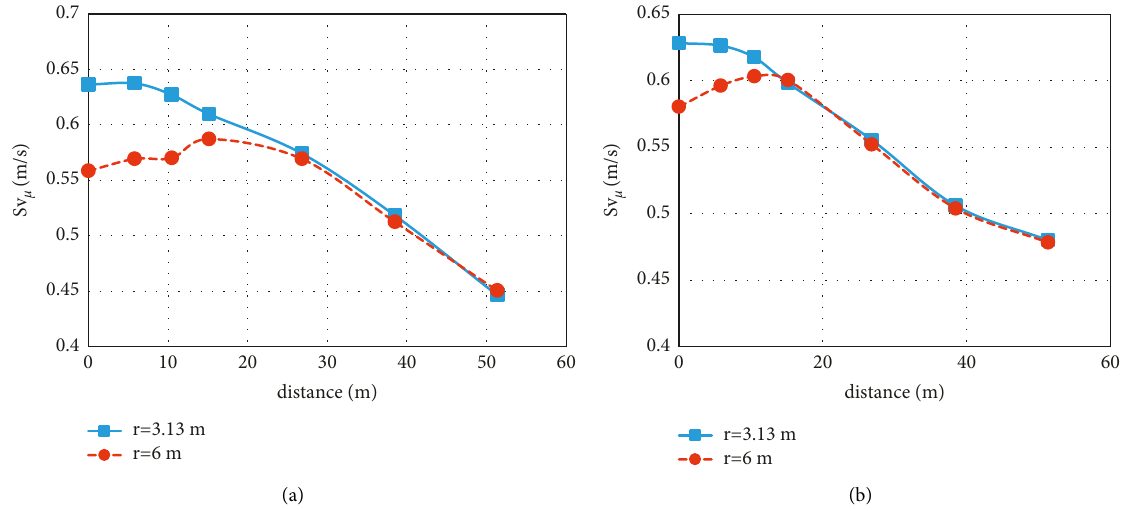
Figure 5: Effect of tunnel radius on ground surface velocity for models (a) 1 and 35 and (b) 10 and 14 of Table 1.